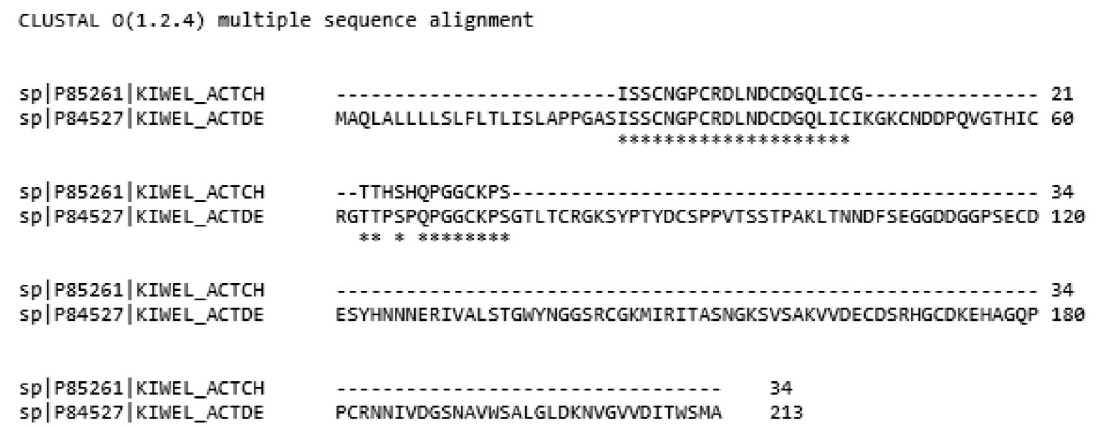
Figure 2. Pairwise sequence alignment of P85261 and P84527.